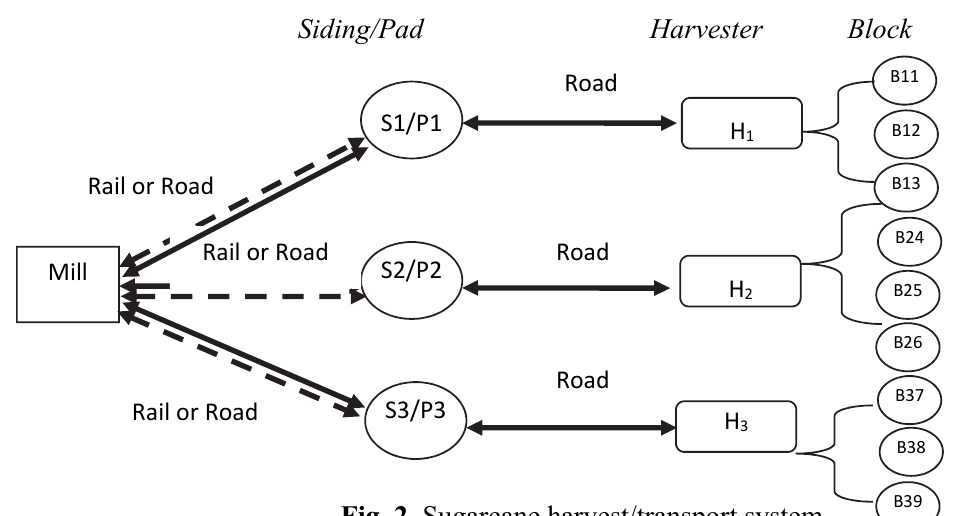
Fig. 2 . Sugarcane harvest/transport